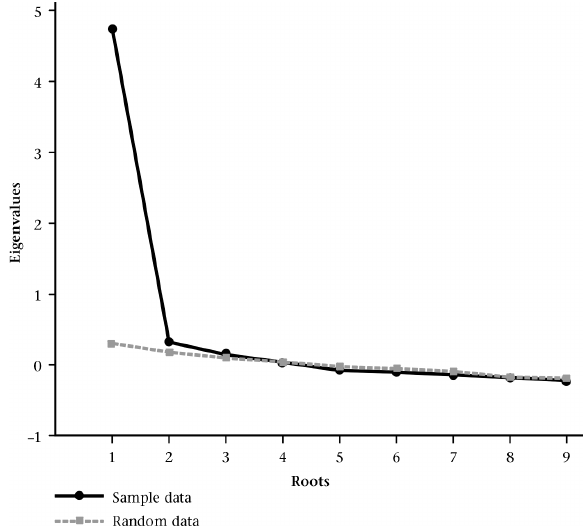
Figure 2. Scree plot and parallel analysis plot for Group